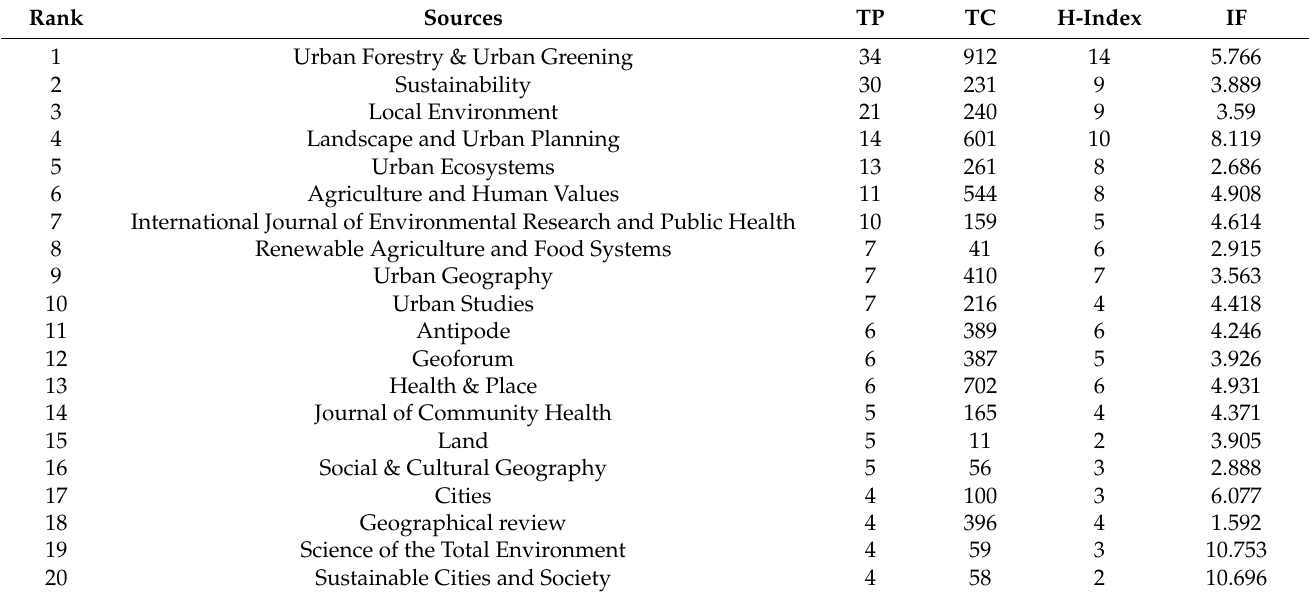
Table 4. The top 20 sources about research on community gardens based on total publications (TP) from 1995 to 2022.